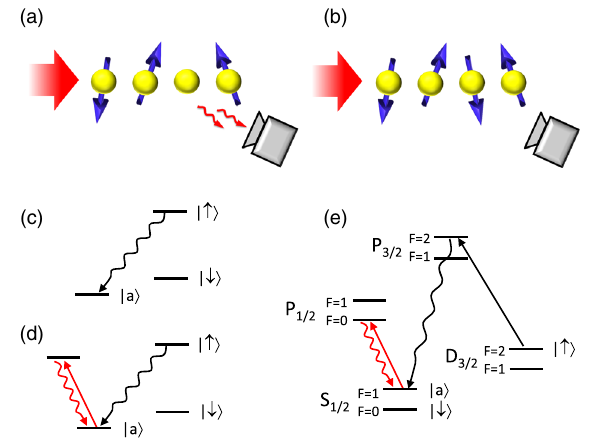
FIG. 1. (a) Experimental setup with a chain of atoms. The population in the auxiliary state j a i is measured by scattering photons off of it. (b) The non-Hermitian model is heralded by the absence of population in j a i , i.e., the absence of fluorescence. (c) j ↑ i decays into the auxiliary state j a i . (d) The population of j a i is measured by exciting it with a laser and detecting the fluores- cence (red arrows). (e) Level scheme for a 171 Yb þ ion, showing optical pumping (black arrows) and detection (red